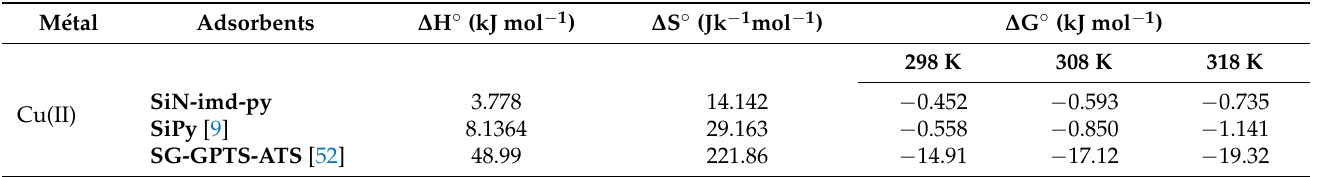
Figure 10. Effect of temperature for the adsorption of metal ions onto SiN-imd-py adsorbent. Table 5. Thermodynamic parameters of SiN-imd-py and other similar adsorbents at various